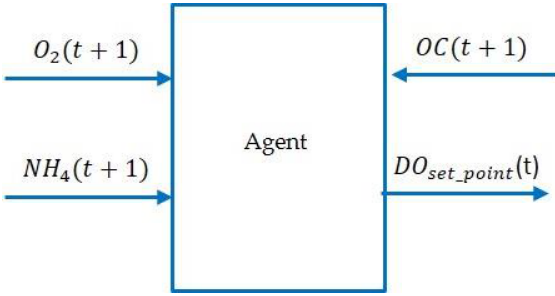
Figure 5. Model-free RL agent structure.